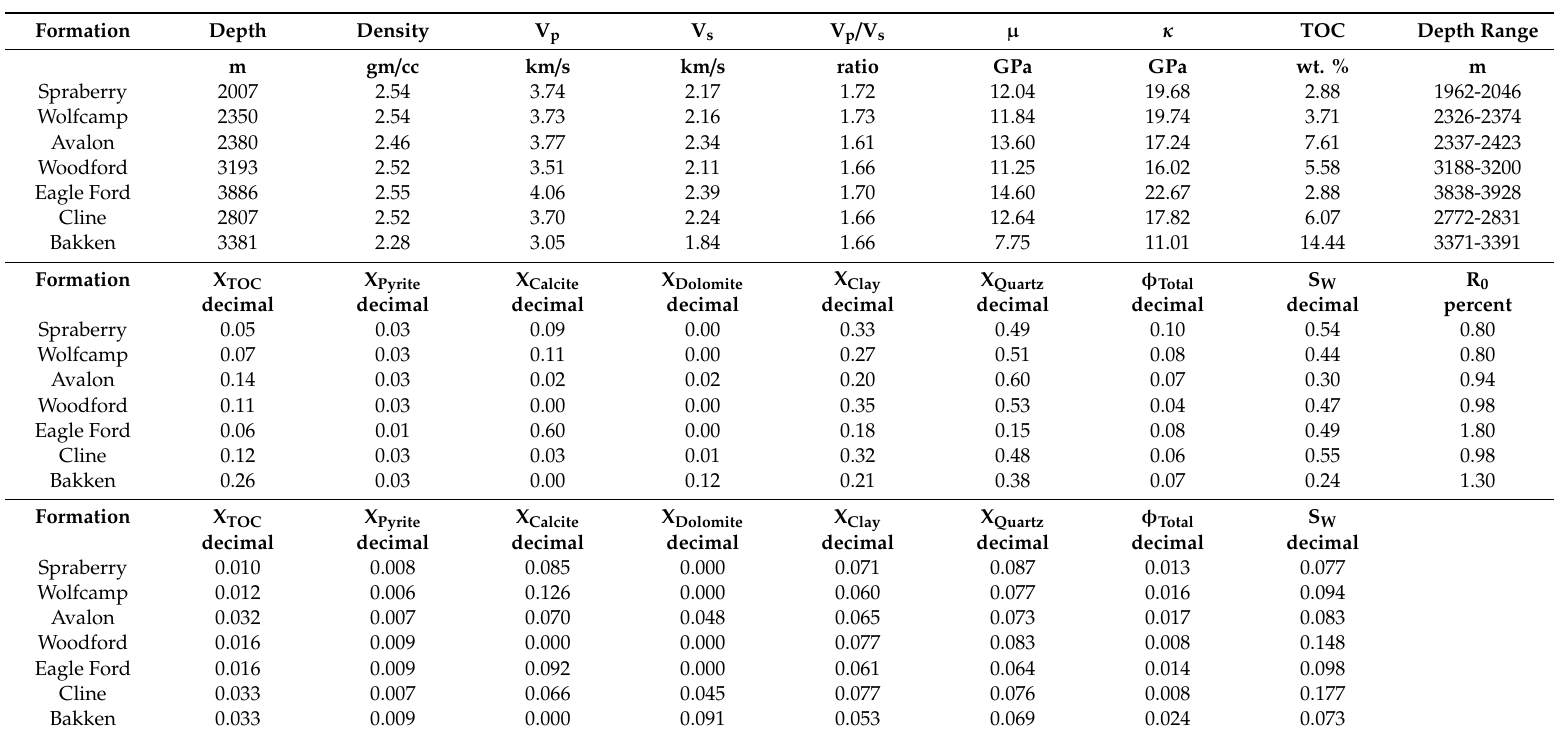
Table 1. Average rock properties from well logs for shale reservoirs studied here. Each formation is represented by only single wells, so these values are not meant to be representative of the entire geographic extent of the formations. High water saturations (greater than 70%) and low TOC volume fractions (less than 1%) are excluded. Reported quantities are mean values for included depths. Depth is mean depth for included datapoints in each formation. Density is mean logged density. V p and V s are mean sonic compressional and shear-wave velocities. R o is percent vitrinite reflectance determined from cuttings and S w is mean decimal water (cid:80) saturation from log analysis. The X i are mineral solid volume fractions from volumetric log analysis such that X i = 1 for organic matter (X TOC ) pyrite (X Pyrite ), calcite (X Calcite ), dolomite (X Dolomite ), clay (X Clay ), and quartz plus feldspars (X Quartz ). TOC is weight percent of total solid organic carbon. X TOC is the volume fraction of solid organic carbon derived from TOC using the Vernik relation [30] which is Equation (6) in [27]. The depth range is the top and base of the logged interval. φ Total is total porosity using measured log density and grain density from solid volume fractions. Standard deviations for volumetric well log calculations of shale reservoirs studied here. Standard deviations corresponding to mean values given above for decimal volume fractions of solid organic matter (X TOC ), pyrite (X Pyrite ), calcite (X Calcite ), dolomite (X Dolomite ), clay (X Clay ) and quartz plus feldspars (X Quartz ), total porosity ( φ Total ), and water saturation (S w